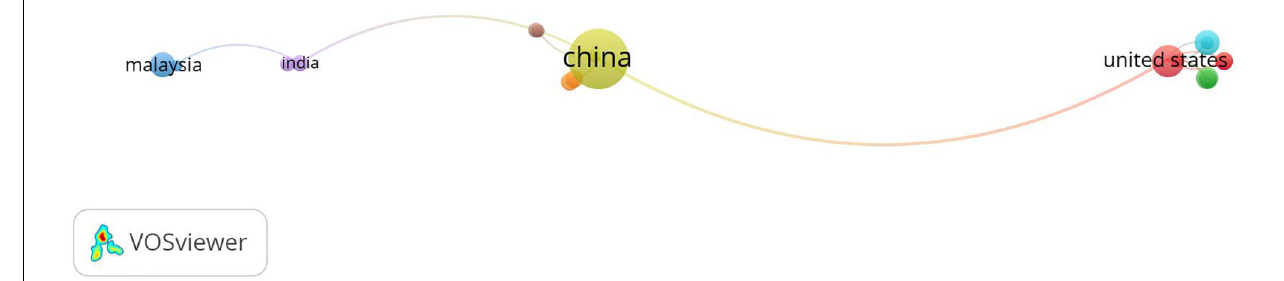
FIGURE 5 | The map of the co-authorship among the countries on English-speaking teaching and